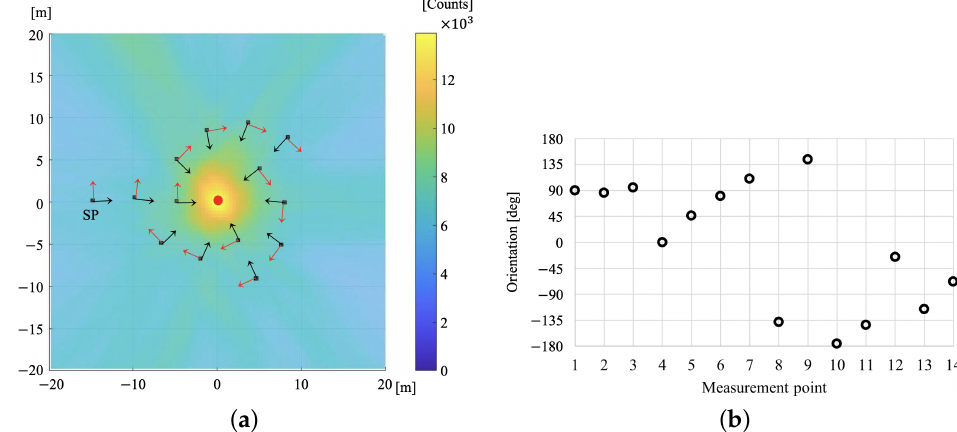
Figure 11. Simulation result of the condition that single radiation source exists: ( a ) SP represents the first measurement point at which the robot started to move, while EP is the position at which gamma-ray measurements were completed. The color bar on the right represents the value added to each pixel via the proposed method. The blue and red arrows represent the directions of the first and second principal components, respectively. The ground truth of the position of the radiation source is represented by a red dot. It was confirmed that the distribution of the radiation source was estimated around the ground truth. In addition, the measurement path was successfully generated as intended. ( b ) The orientation of the detector was zero when X axis was facing up, and clockwise rotation was defined as